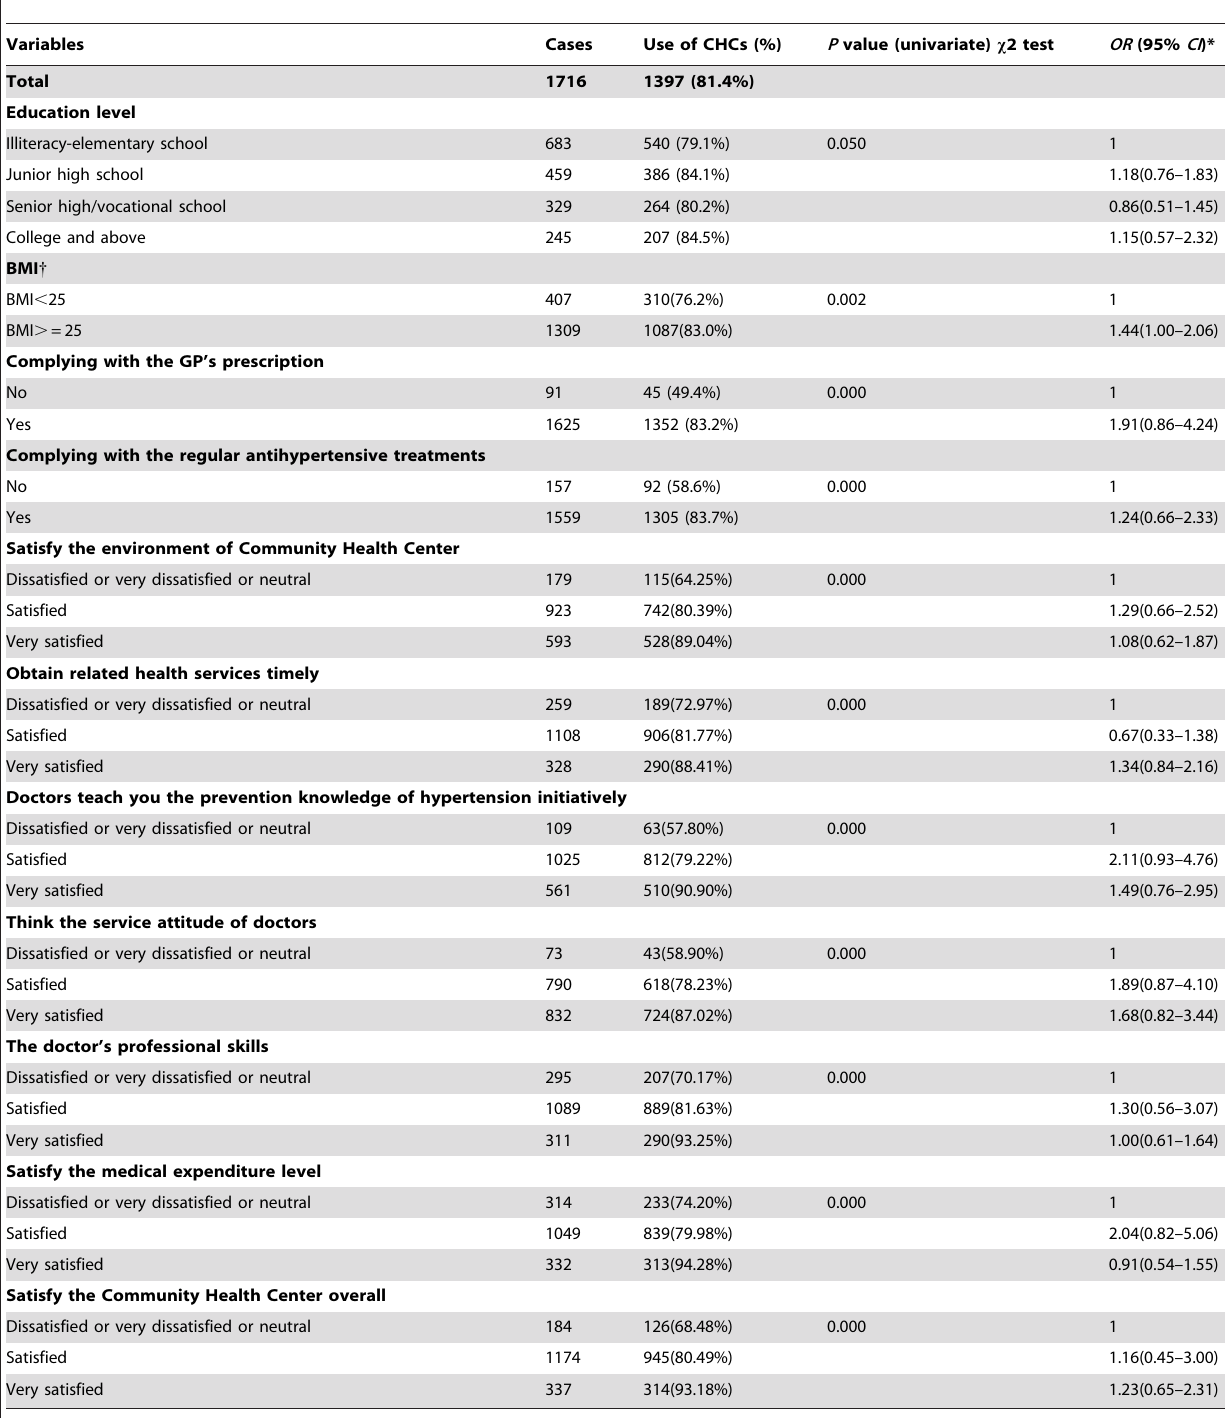
Table 3. Factors associated with the regular use of CHCs for the management of hypertension (This table shows the statistically significant results of univariate analyses and the statistically non-significant results of multiple logistic regression